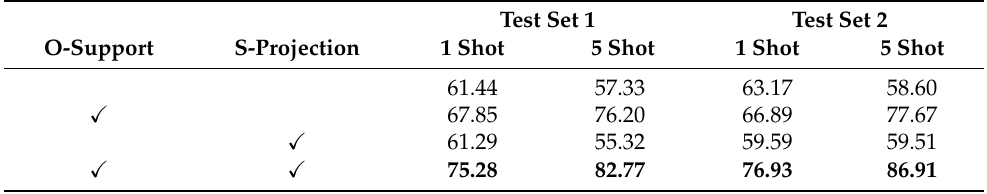
Table 4. Performance results of different model setting. O-support means optimizing support features along with the query feature, and S-projection means shared projection. Bold type indicates the best performance. Test Set